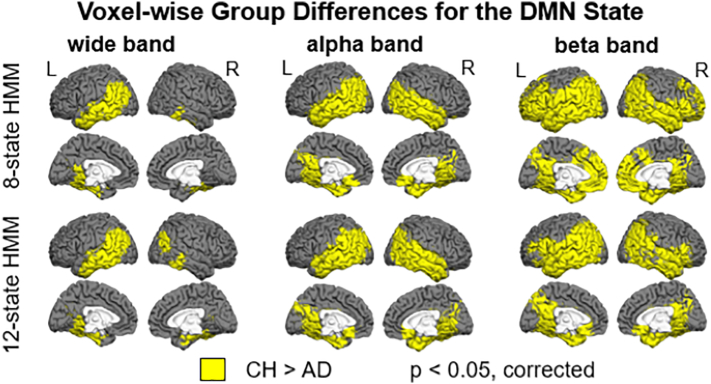
Maps of group differences in the voxel-wise DMN state-specific activity changes, obtained in the HMM inferred with 8 states (top) and 12 states (bottom). Brain voxels where the state-specific enhancement in the oscillatory amplitude was reduced in the AD relative to CH group are shown in yellow color for the wide band (4–30 Hz) in the left panel, the alpha band (8–12 Hz) in the central panel, and the beta band (15–30 Hz) in the right panel.